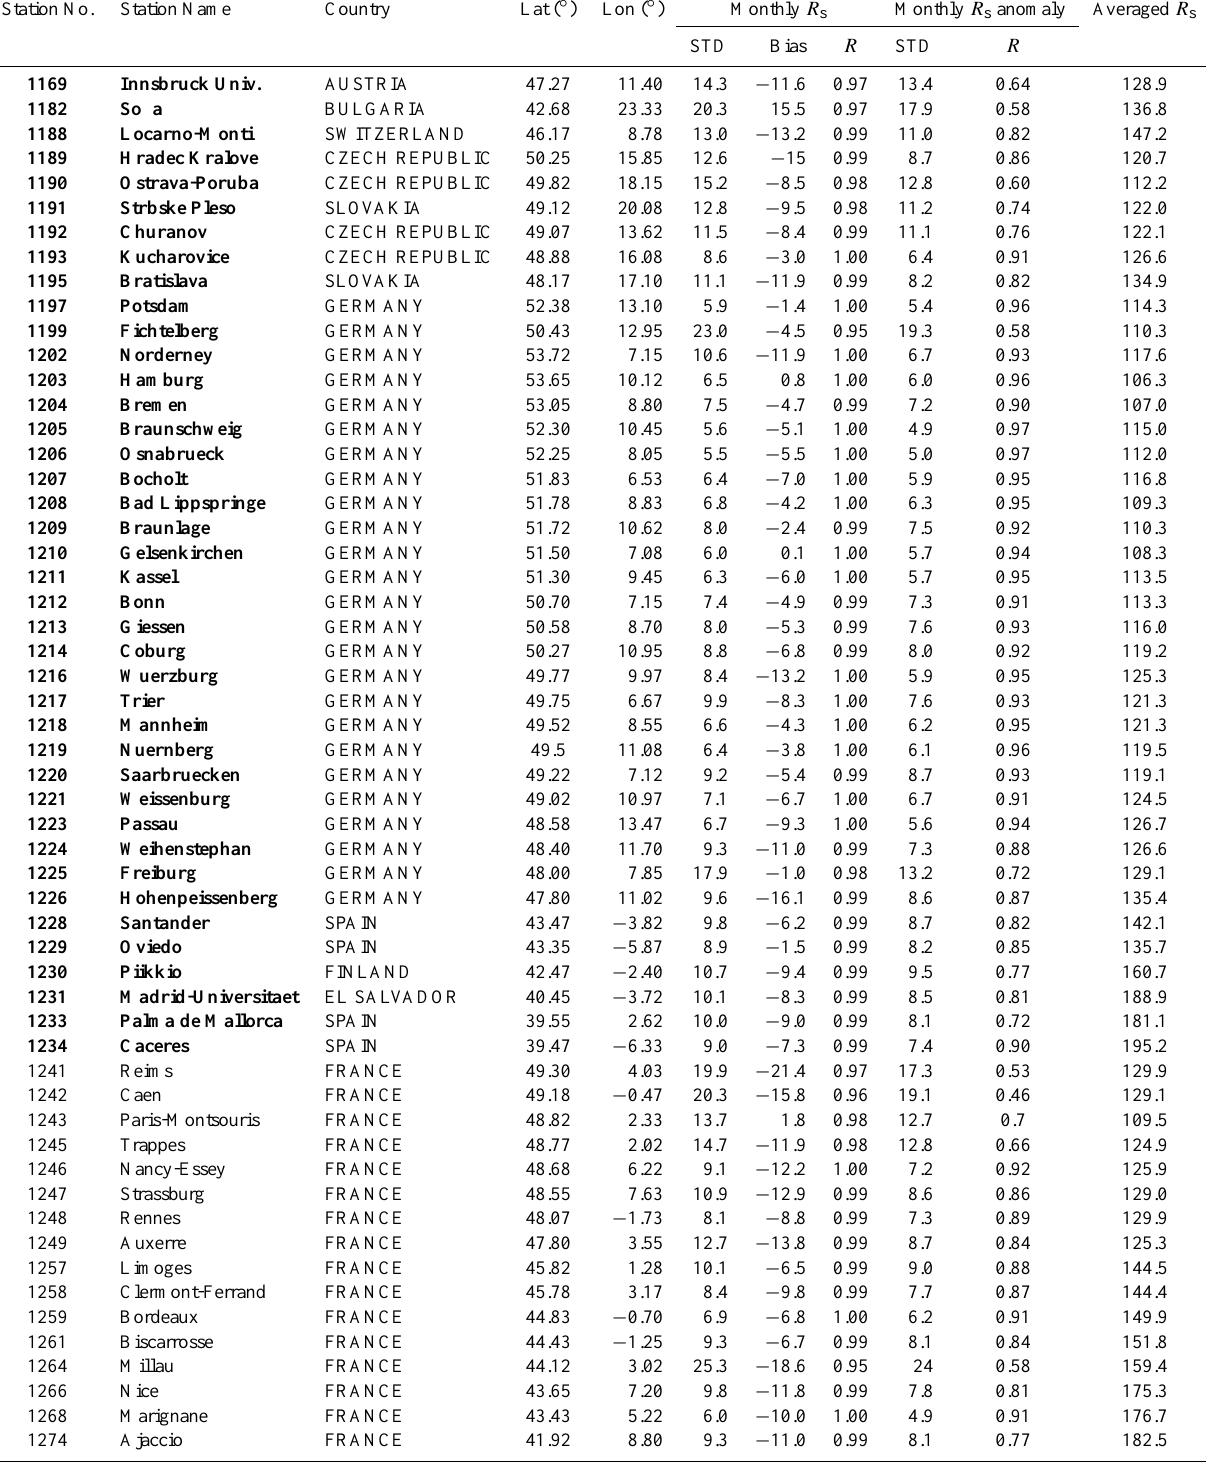
Table 1. A summary of the locations of the 137 stations in Europe and China where GEBA R s measurements and estimates from SunDu and aerosol optical depth (AOD) overlap for at least 84 months. The statistical parameters of the comparison between R s measurements and estimates are shown as standard deviation (STD), bias and averaged R s in Wm − 2 . To show the capability of the method to quantify the effect of clouds on R s , the statistical parameters of the comparisons of predicted and measured monthly R s anomalies (seasonal cycle removed) are also shown. Data at site names in bold were used to calibrate our method and others are used to validate the method. Station